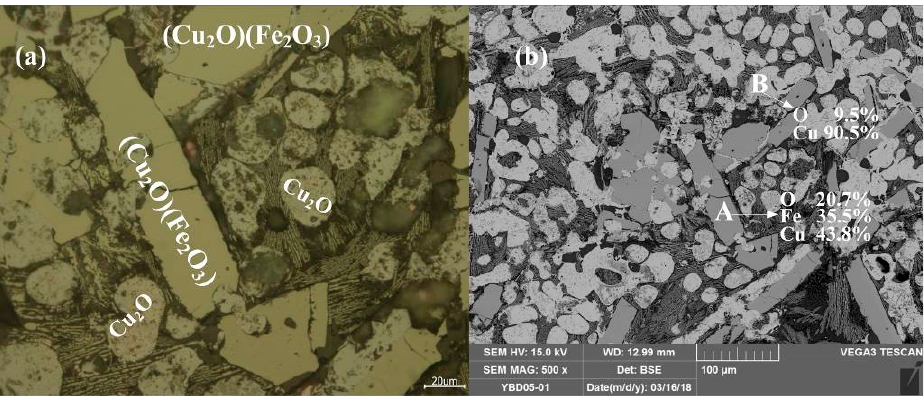
Figure 12. Optical micrograph ( a ) and SEM backscattered electron image ( b ) of Sample YBD07: The backsca tt ered electron image at a higher magni fi cation is shown